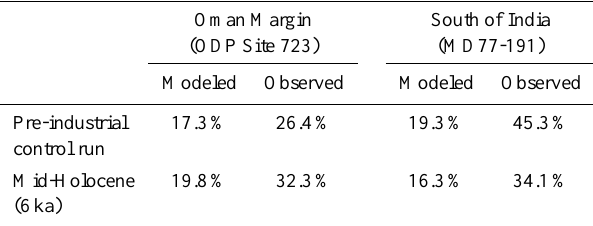
Table 2. Comparison of modelled and observed G. bulloides abun- dance (%) in foraminifer assemblages at the locations of ODP Site 723 and core MD77-191, at 6kaBP and for the modern control run (considered equivalent to uppermost Holocene observations). The observed G. bulloides abundances at core MD77-191 and ODP Site 723 are mean values (5-point window) derived from the bulk data obtained by Ml´eneck-Vautravers (1997) and Gupta et al. (2003; rescaled based on Anderson et al., 2010),